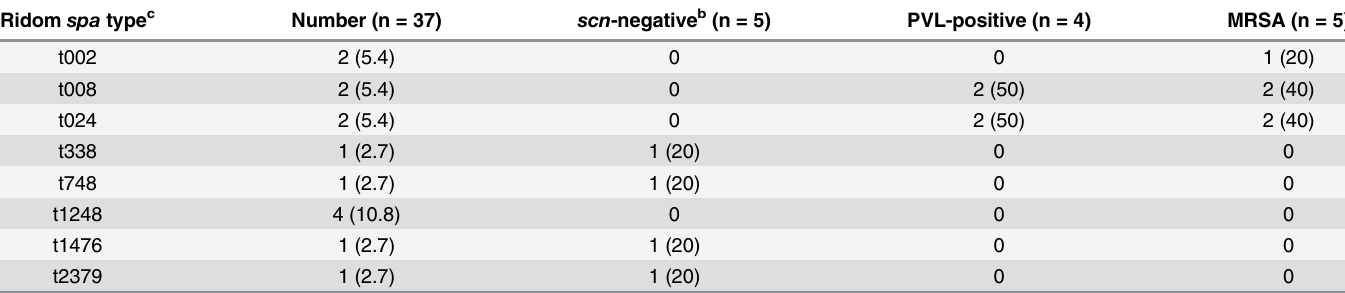
Table 3. Spa types and genetic characteristics of select S . aureus isolates recovered from US beefpacking workers (n = 37 carriers) a . Ridom spa type